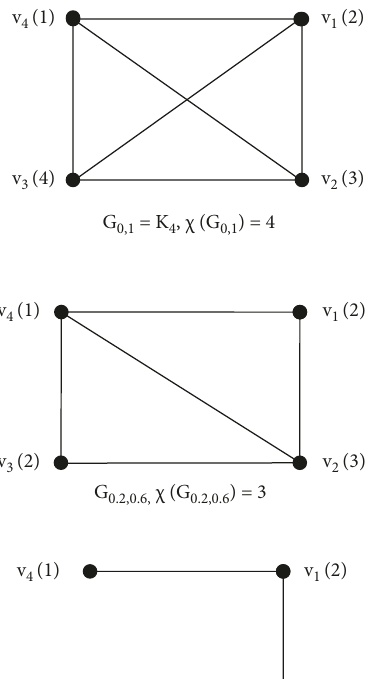
| , | E | , χ ( G ) , and P I ( G , k ) of α , β α , β α , β α , β